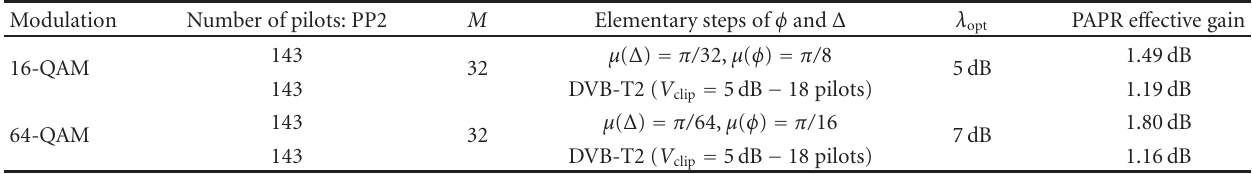
Table 2: Optimal parameters using the proposed technique, 2K mode.